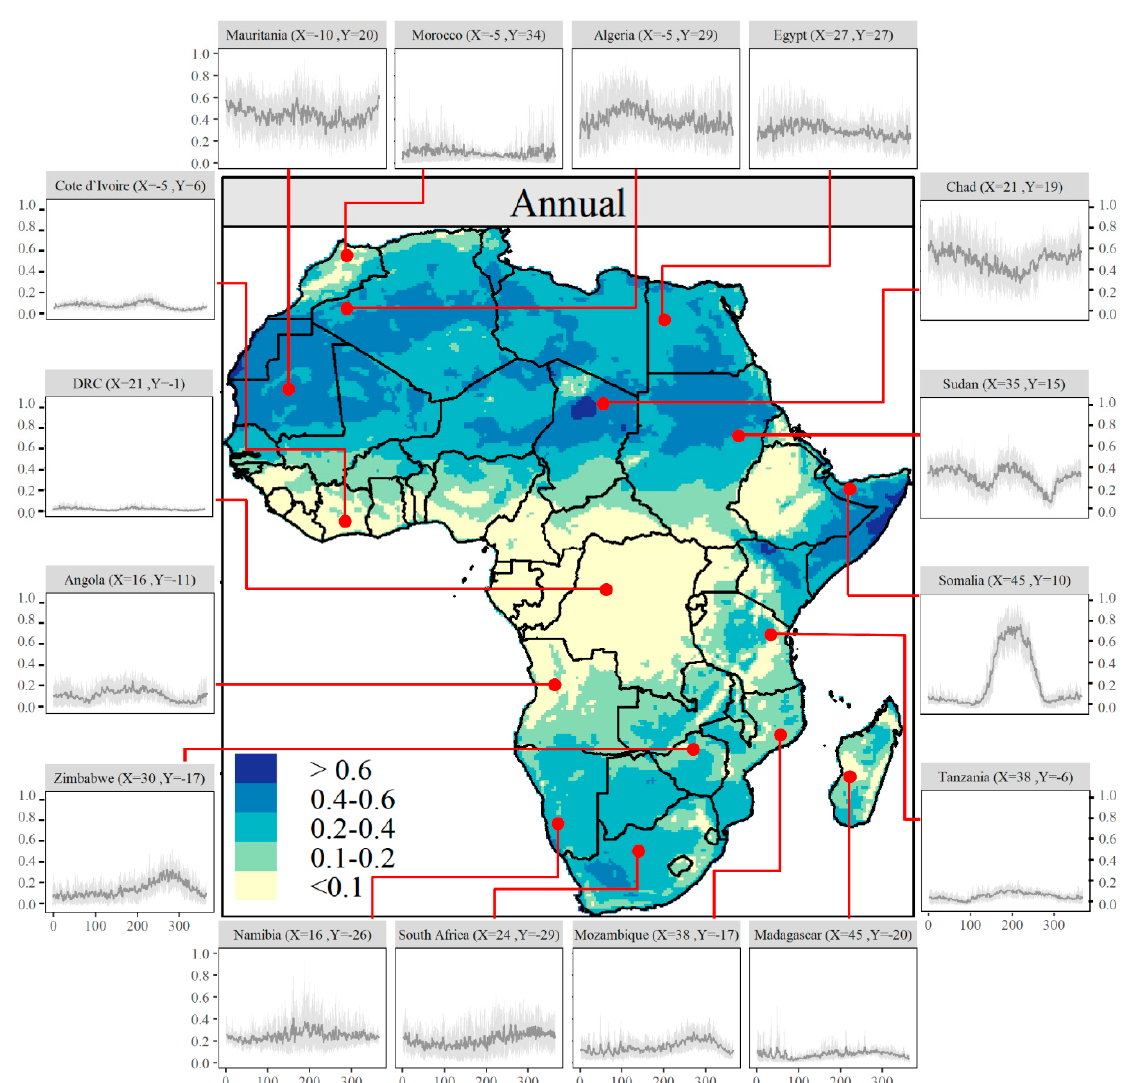
Figure 1. The mean wind power potential in terms of CF at annual scale over the 2000–2017 period in the center. The mean seasonal CFs are presented in Figure S1 in Supplementary Materials. The figures around the Annual CF show the variability of daily CF values (unitless) for 16 sample grid points in different climates. The y -axis and x -axis in small graphs exhibit the values of CF (from 0 (no wind power) to 1 (wind power equal to rated power of the turbine)) and time of the year (days from January to December), respectively. All the figures have the same scale. The solid grey line is the mean and the boundaries are showing 10th and 90th percentiles of CF values over the study period (2000–2017). Note that the wind resource (mean and variability) can vary a lot from one location to the other within a country.